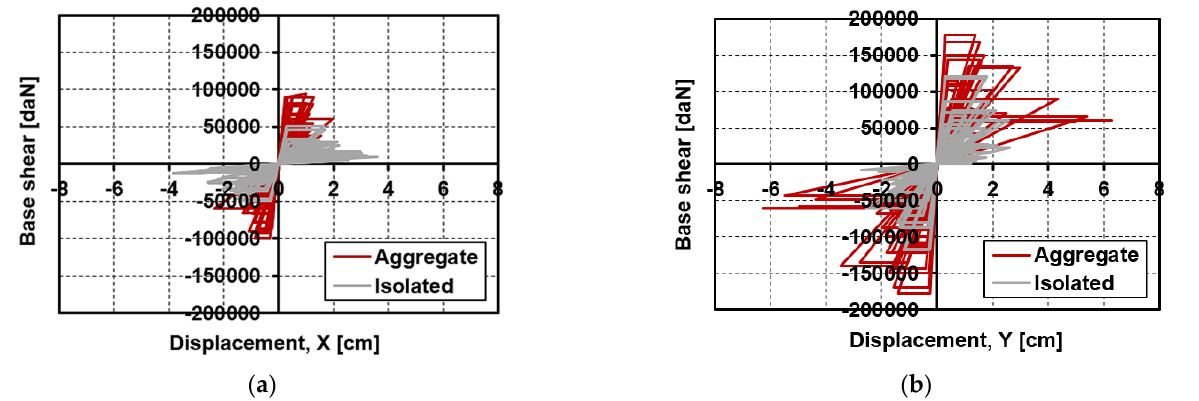
Figure 7. Capacity curves in X ( a ) and Y ( b ) directions for each SU in aggregate and isolated